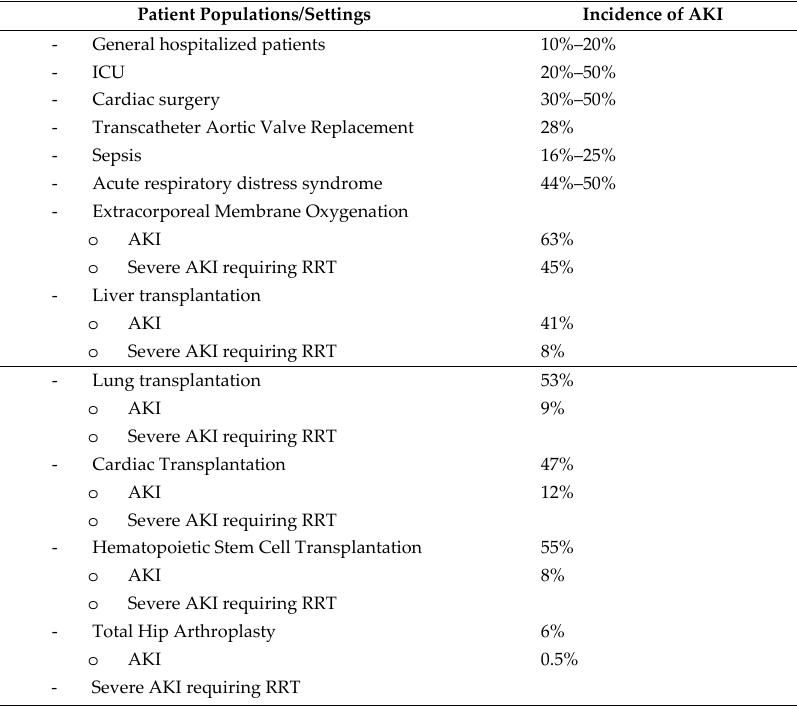
Table 3. Diagnostic tests in patients with AKI [1,105,106]. Diagnostic